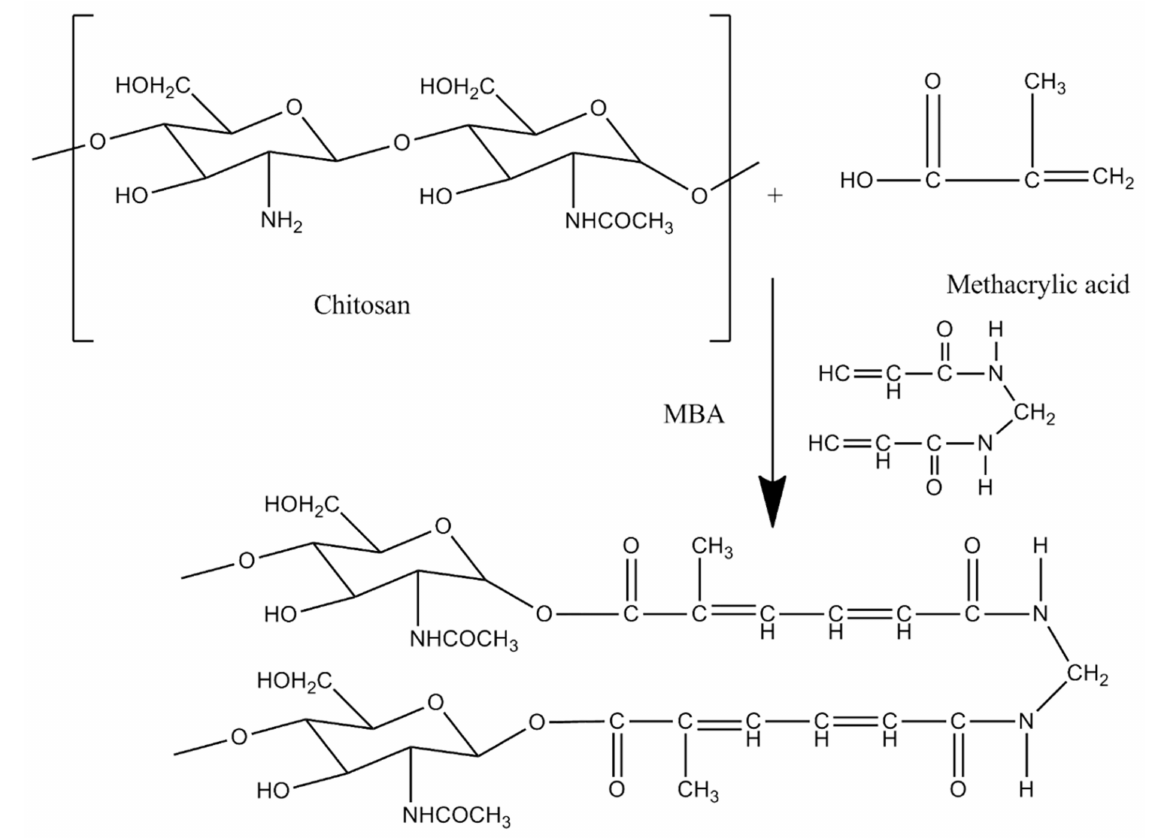
Figure 10. Proposed schematic diagram of the prepared